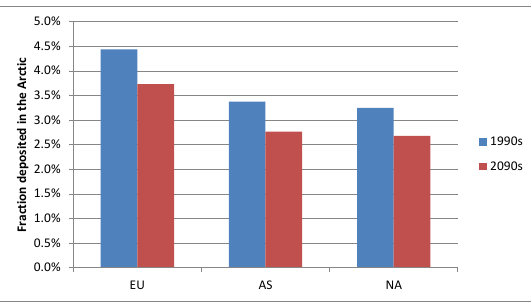
Figure 5. The fraction of the total emitted Hg deposited in the Arctic originating from each of the three source areas: Europe (EU), Asia (AS), and North America (NA) in the 1990s (Blue) and in the 2090s (red).